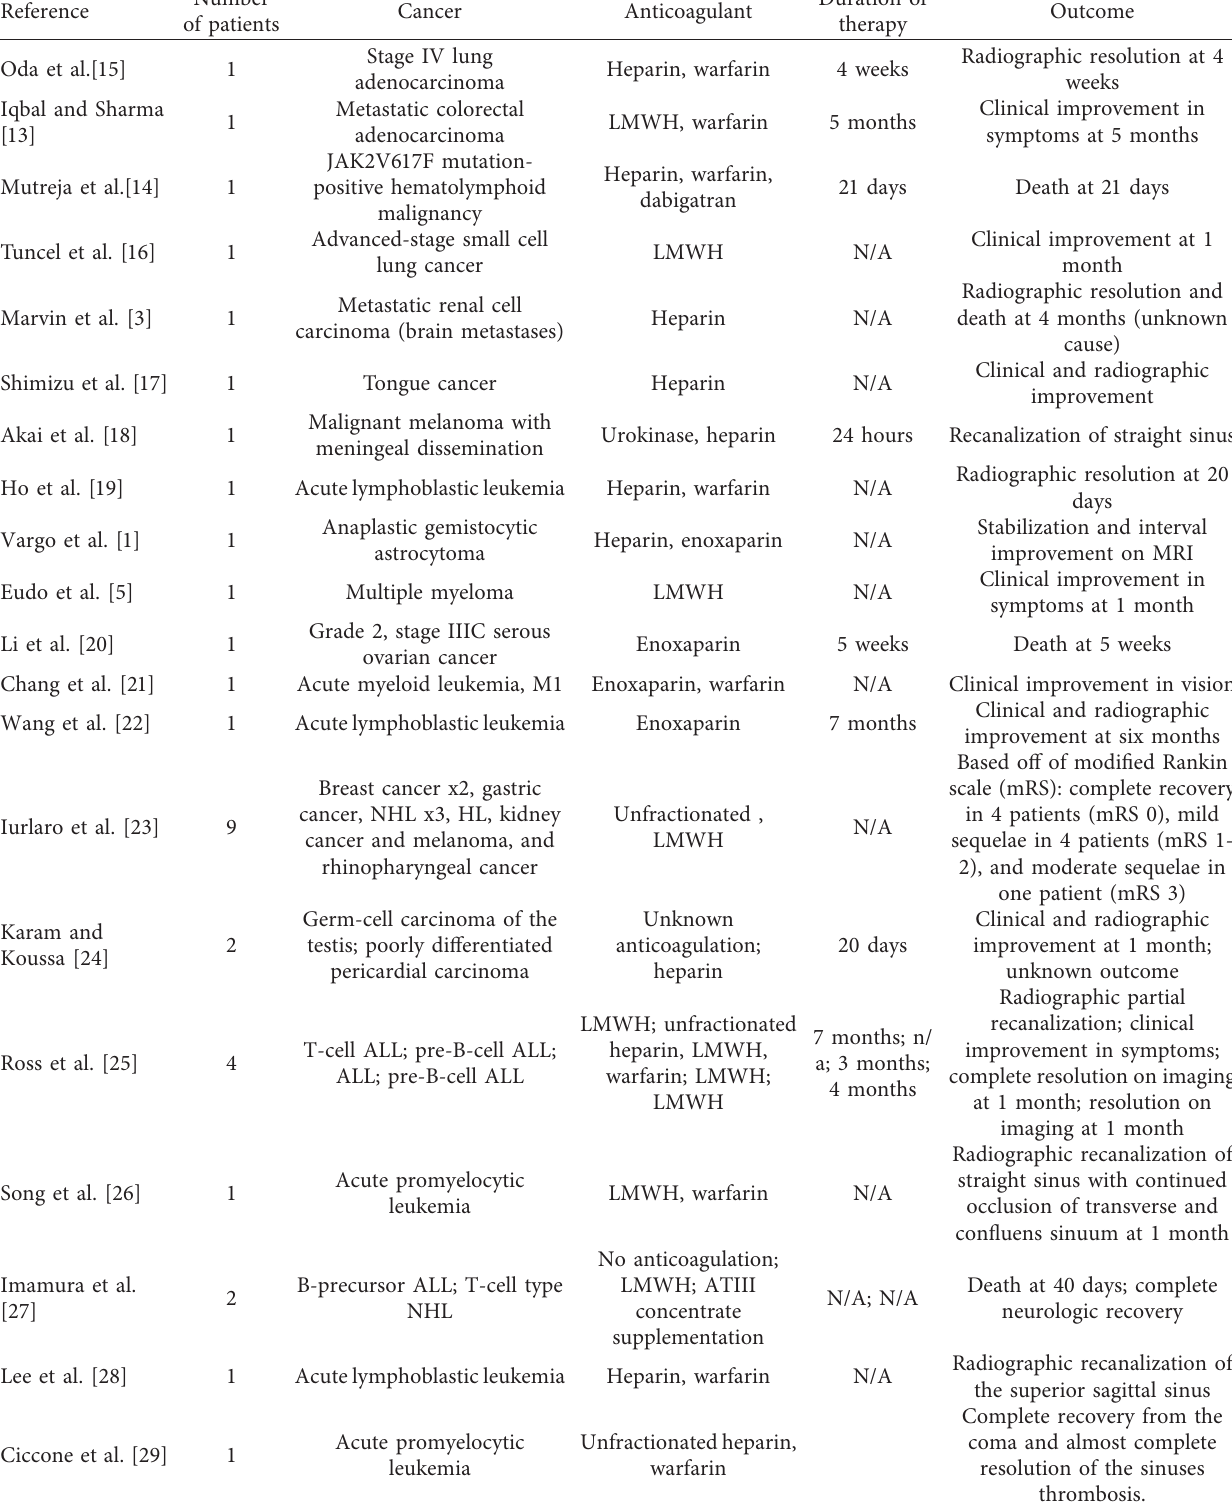
Table 1: Review of the literature describing sinus thromboses in